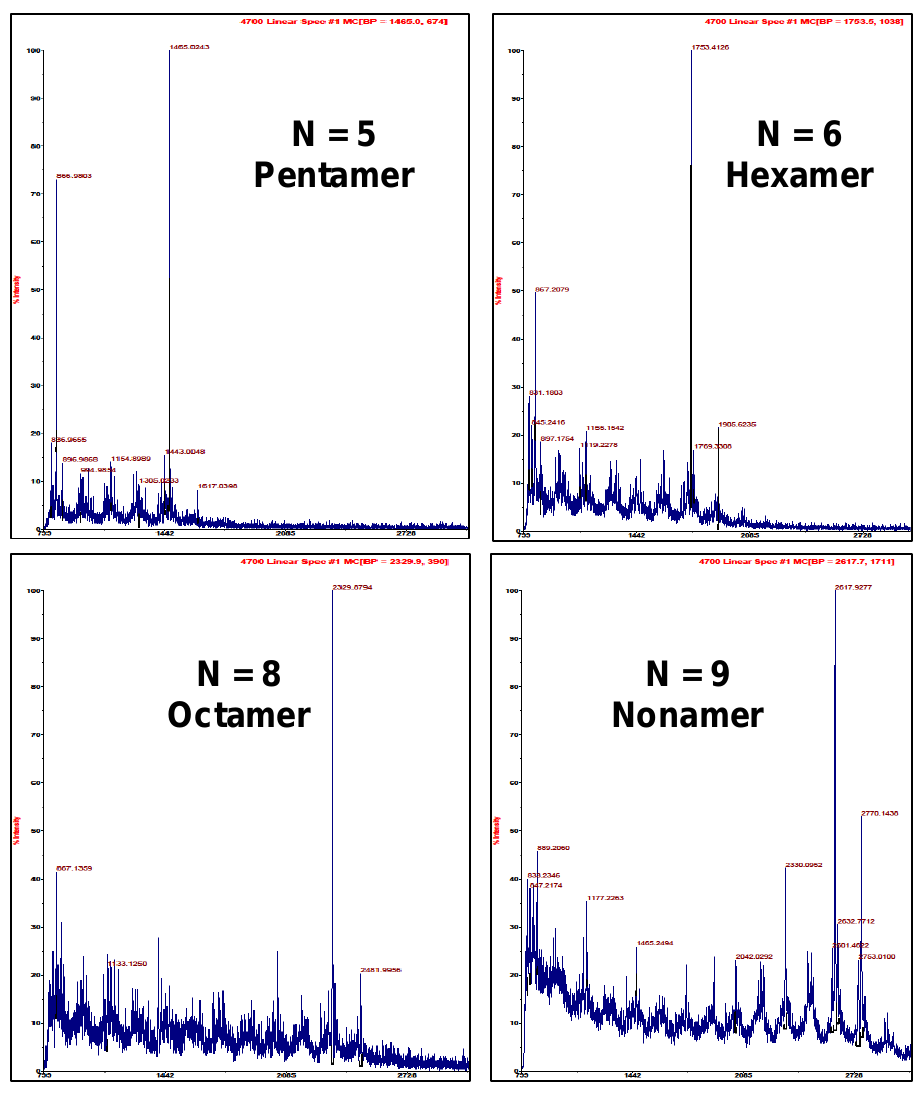
Figure 3. MALDI mass spectra of selected cocoa procyanidin standards.